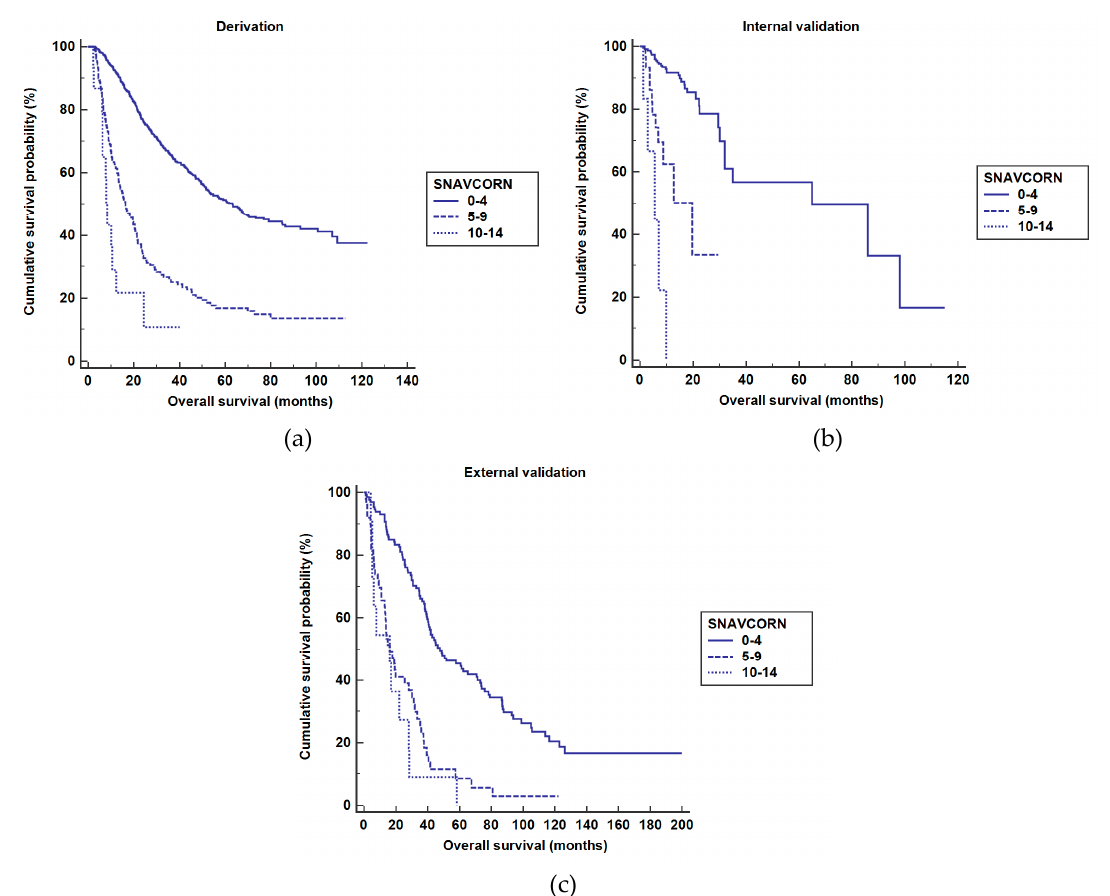
Figure 1. Stratification of patients according to SNAVCORN score ( a ) Derivation set. The median OS was significantly higher in the low-risk group at 63.3 (95% CI 52.7–74.5) months, followed by the intermediate-risk (16.3 (95% CI 12.0–20.6) months) and high-risk (8.3 (95% CI 7.0–9.6) months) groups (log-rank test, p < 0.001). ( b ) Internal validation set. The median OS was significantly higher in the